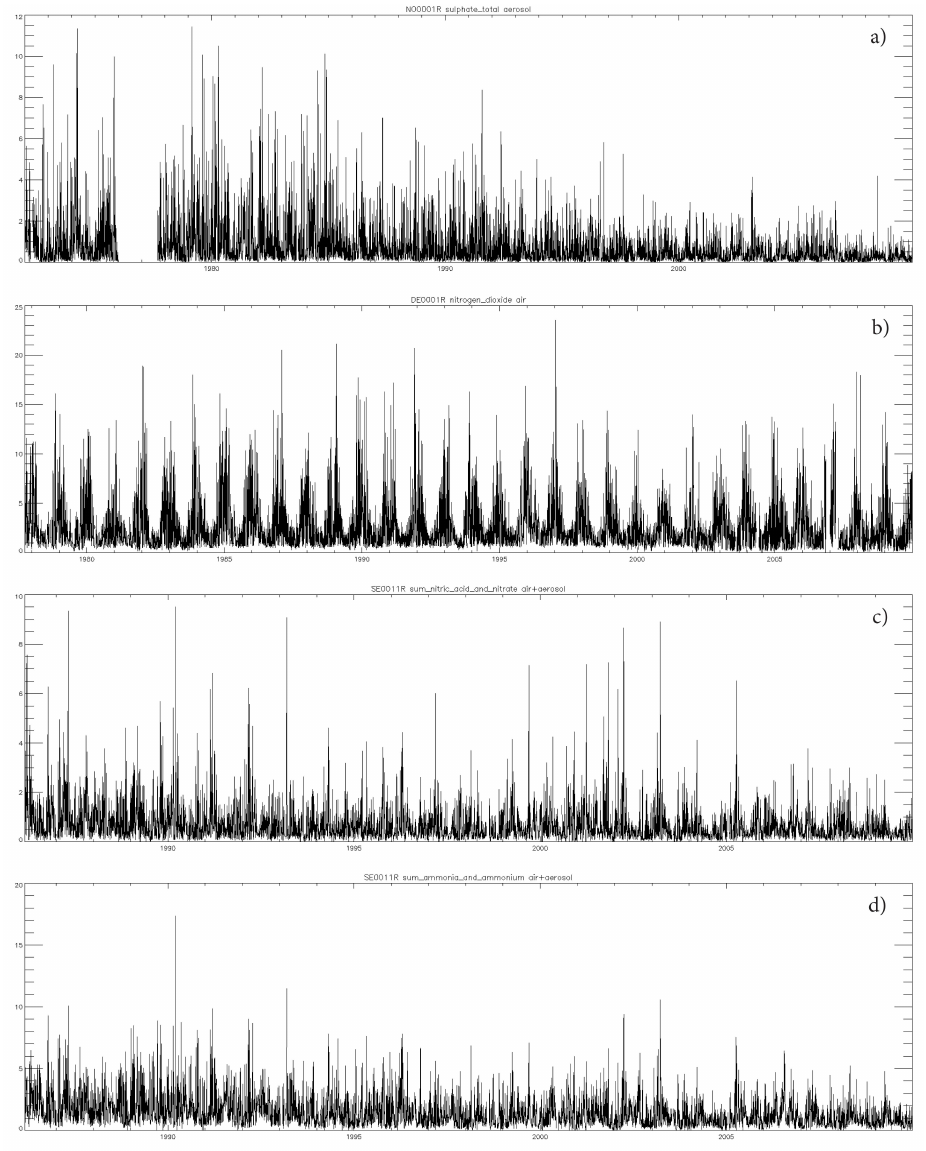
Fig. 4. Time series of daily air concentrations of (a) SO 2 − Germany and (c) sum HNO 3 + NO −